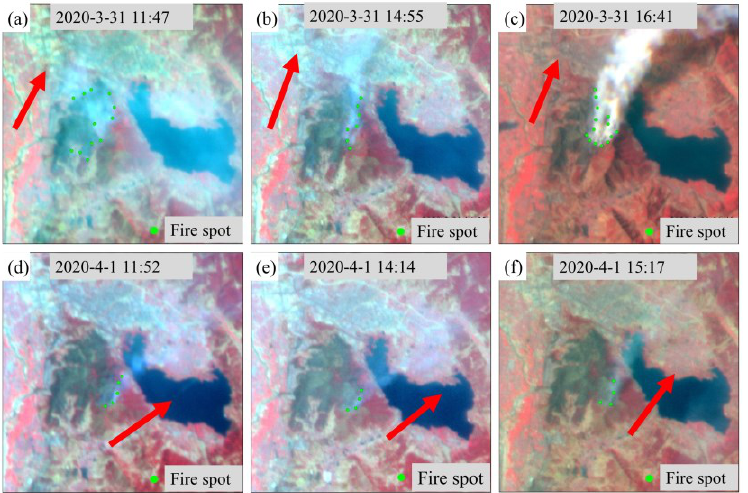
Figure 5. Forest fire monitoring in Jingjiu Township based on GF-4 satellite data. ( a – f ) are the fire and smoke distribution at 11:47 a.m. on 31 March, 14:55 p.m. on 31 March, 16:41 p.m. on 31 March, 11:52 a.m. on 1 April, 14:14 p.m. on 1 April and 15:17 p.m. on 1 April in 2020, respectively. The fire line time series of Jingjiu Township was extracted from multi-source remote sensing data (Figure 6). At 13:20 p.m. on 30 March, the burned area was 2.80 km 2 (Figure 6a), and by 10:55 a.m. on 31 March, the burned area had reached 12.10 km 2 (Figure 6b). By 14:55 p.m., the fire burned area had risen up to 17.98 km 2 (Figure 6d), and the fire at this stage had an accelerating trend. By 15:17 p.m. on 1 April, the fire burned area had reached 26.45 km 2 (Figure 6h), and the fire was under control at this time. The fire was extinguished on 2 April, and the final area burned was 30.91 km 2 .